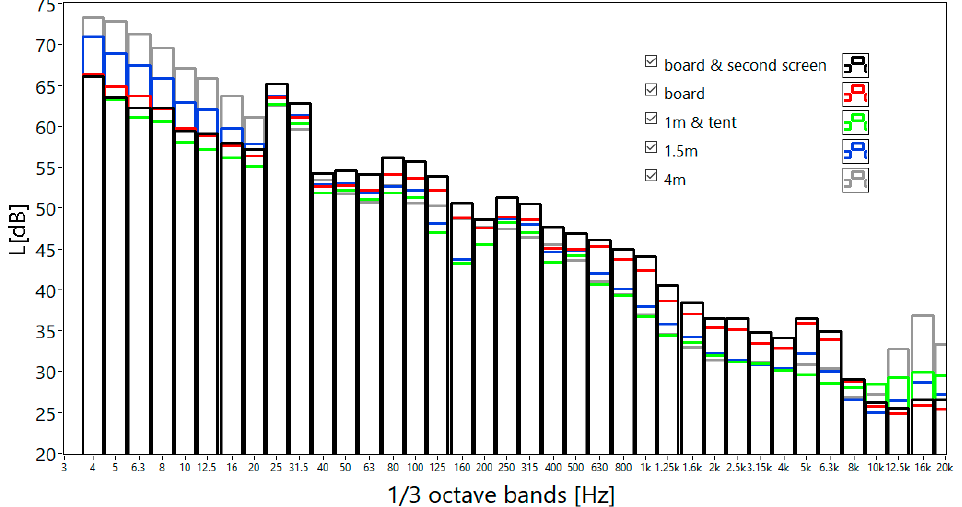
Figure 15. Wind turbine noise. 1/3 octave spectrum, average wind speed—2.1 m/s, max wind speed—4.5 m/s.